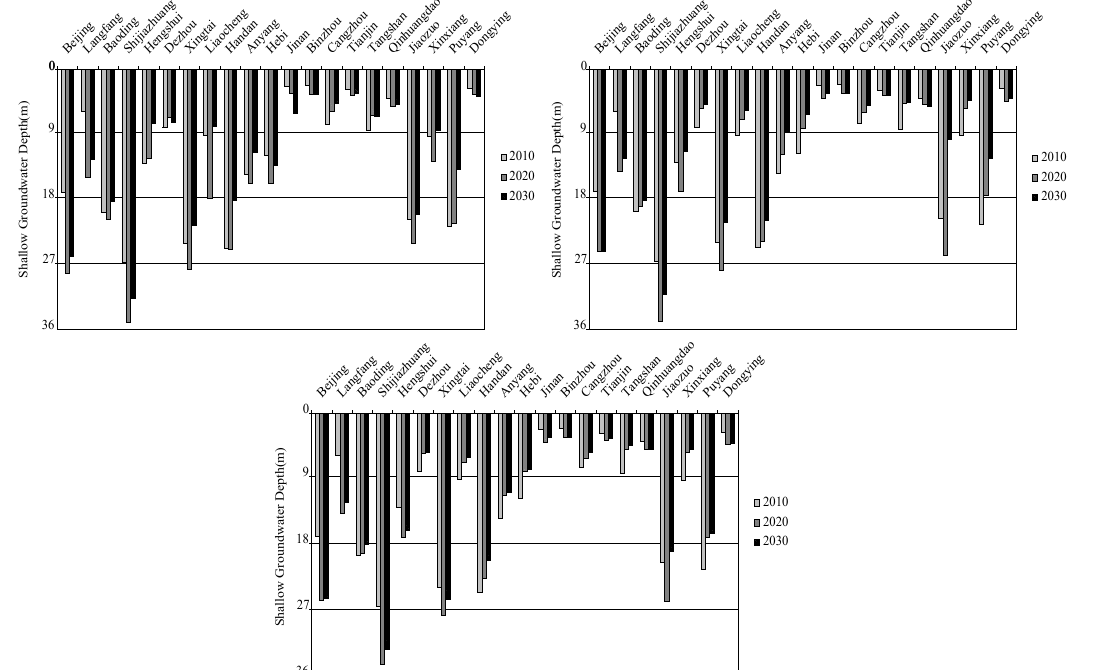
Fig. 5 The shallow groundwater depth change of schemes F1, F2 and F3 under the hydrological series from 1956 to